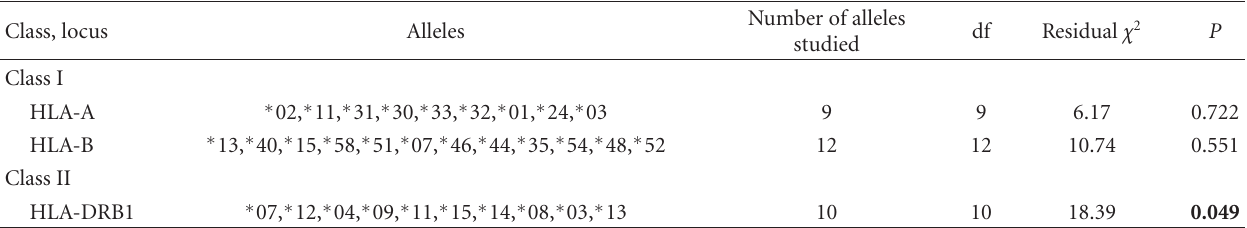
Table 2: The polymorphism and susceptibility of class I and II loci in the major histocompatibility complex to hemorrhagic fever with renal